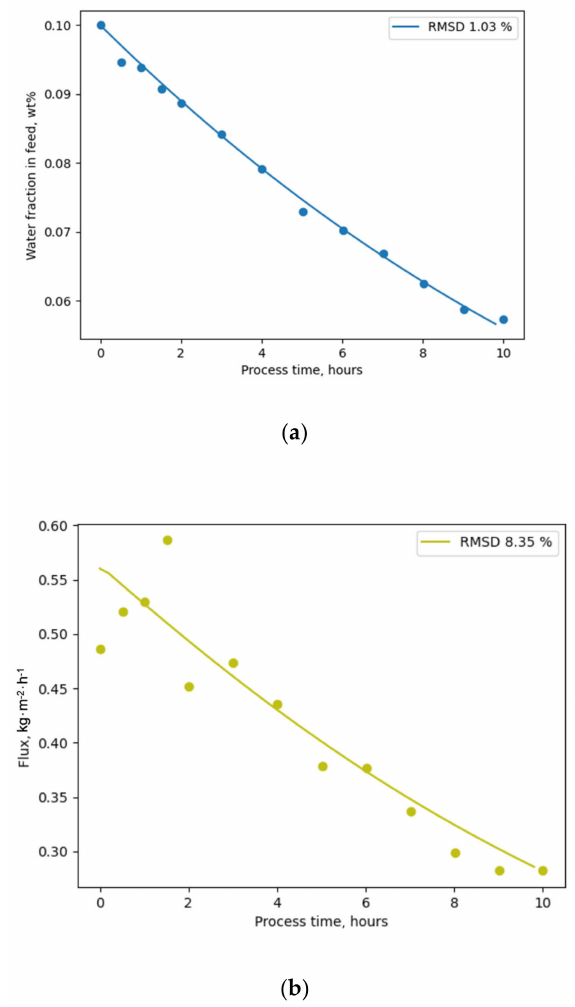
Figure 5. Comparison of experimental (dots) [45] and modelled values with PyVaporation on the basis of literature [24] (curves) data on the water fraction in feed ( a ) and water flux ( b ) as functions of processing time along with the corresponding RMSD